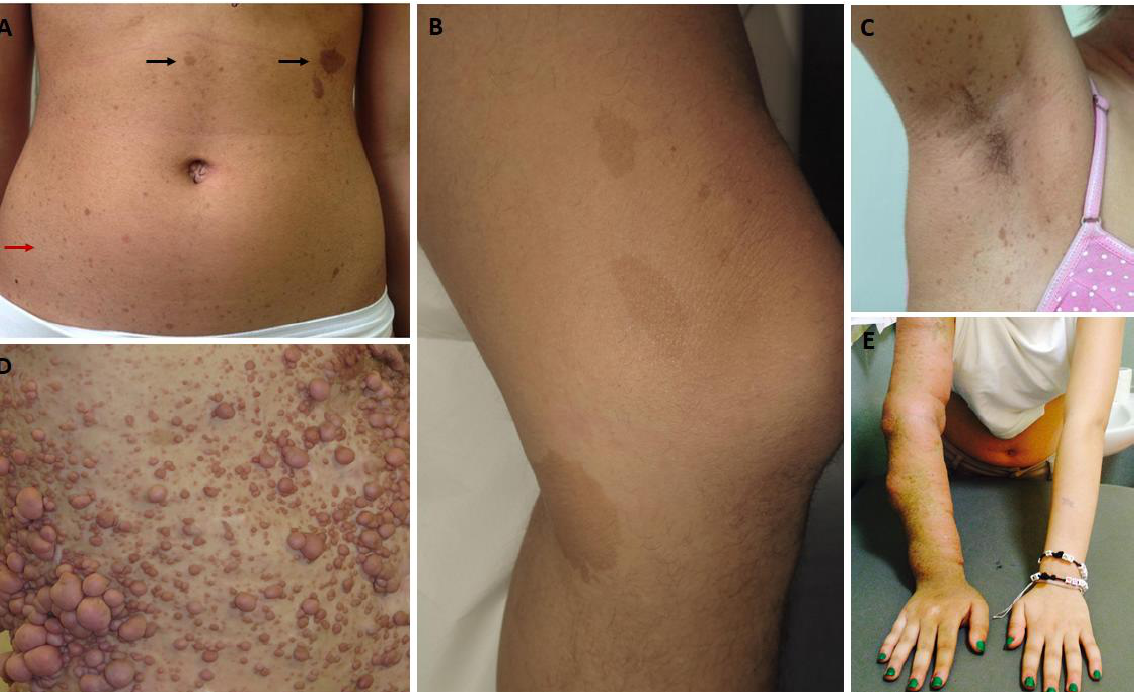
Figure 2. Typical manifestations of neurofibromatosis type 1 (NF1): café au lait macules characterized by linear margins ( A , B ), homogeneous color, and rounded/oval shape (( A ); black arrow), with dimension > 1.5 cm in post-pubertal age; atypical freckles on the abdomen (( A ); red arrow); typical freckles in the axillary fold ( C ); multiple cutaneous neurofibromas typically found in adulthood — note the pinkish color and rounded shape ( D ); extensive plexiform neurofibroma involving the entire upper limb, with hyperchromic skin lesions in the affected area and secondary deformity ( E ). The criteria were recently reviewed by a group of international experts (Table 1) [11]. Table 1. Revised diagnostic criteria for neurofibromatosis type 1 as reported by Legius et al. [11]. Revised Diagnostic Criteria for Neurofibromatosis Type 1